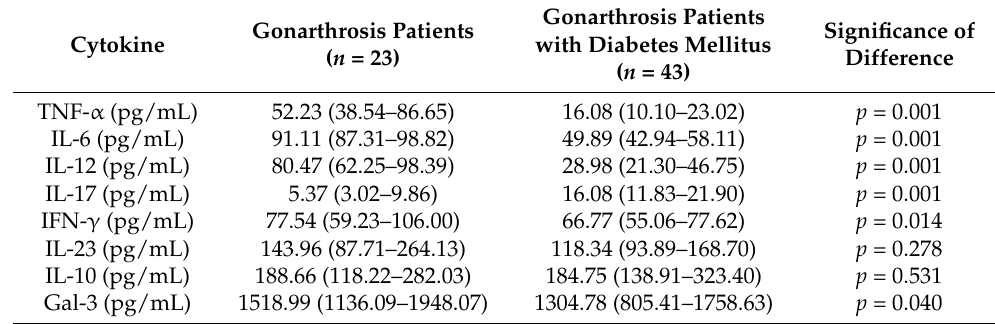
Table 2. TNF- α , IL-6, IL-12, IL-117, IFN- γ , IL-23, IL-10, and Gal-3 (median and interquartile range) in gonarthrosis patients with and without diabetes